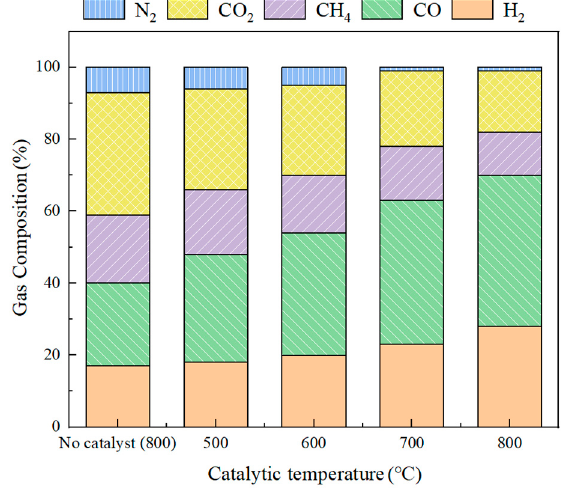
Figure 5. Effect of catalytic temperature on pyrolysis gas composition of pine sawdust.